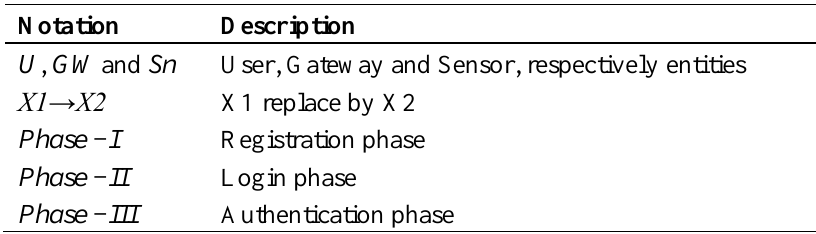
Table 2. Additional notations.